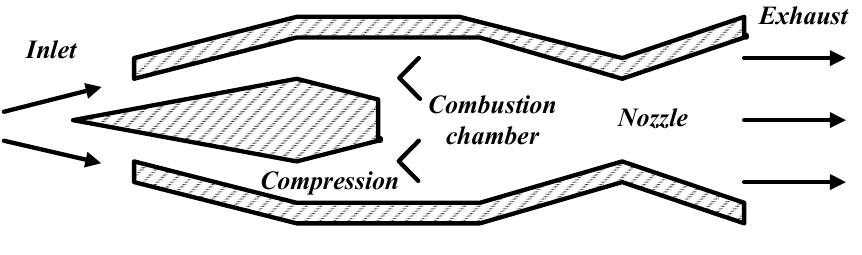
Figure 10. Ramjet Engine [75].